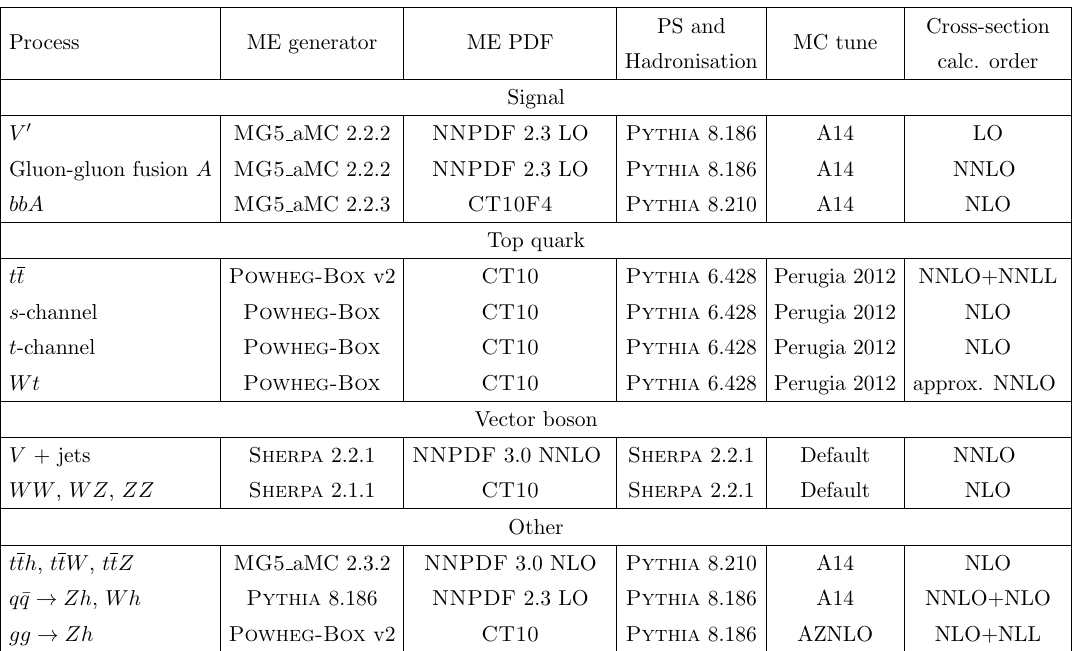
Table 1. Event generators used for the simulation of the signal and background processes. The acronyms ME and PS are used for matrix element and parton shower,